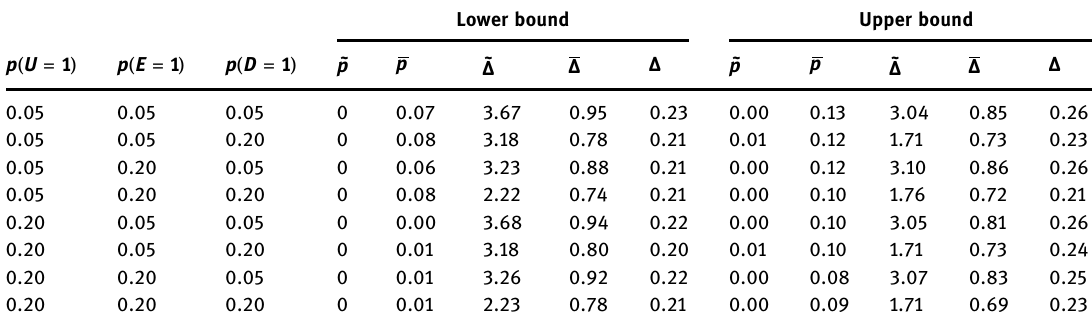
Table 4: Simulation results with σ 1 = , and parameter values that are 15% more conservative than the true values. p ˜ and p are the proportions of times that AS ’ bounds and our bounds are tighter than DV ’ s bounds, respectively. Δ˜ , Δ and Δ are the mean absolute distance between the log of the bound and the log of the true risk ratio for AS ’ bounds, our bounds and DV ’ s bounds, respectively Lower bound Upper bound p U 1 ( = ) p E 1 ( = ) p D